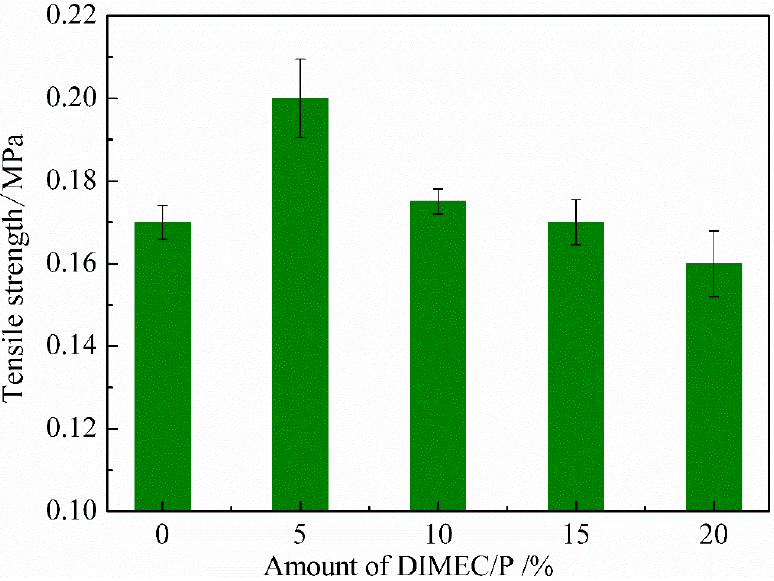
Figure 12. Tensile strength of CPFs.